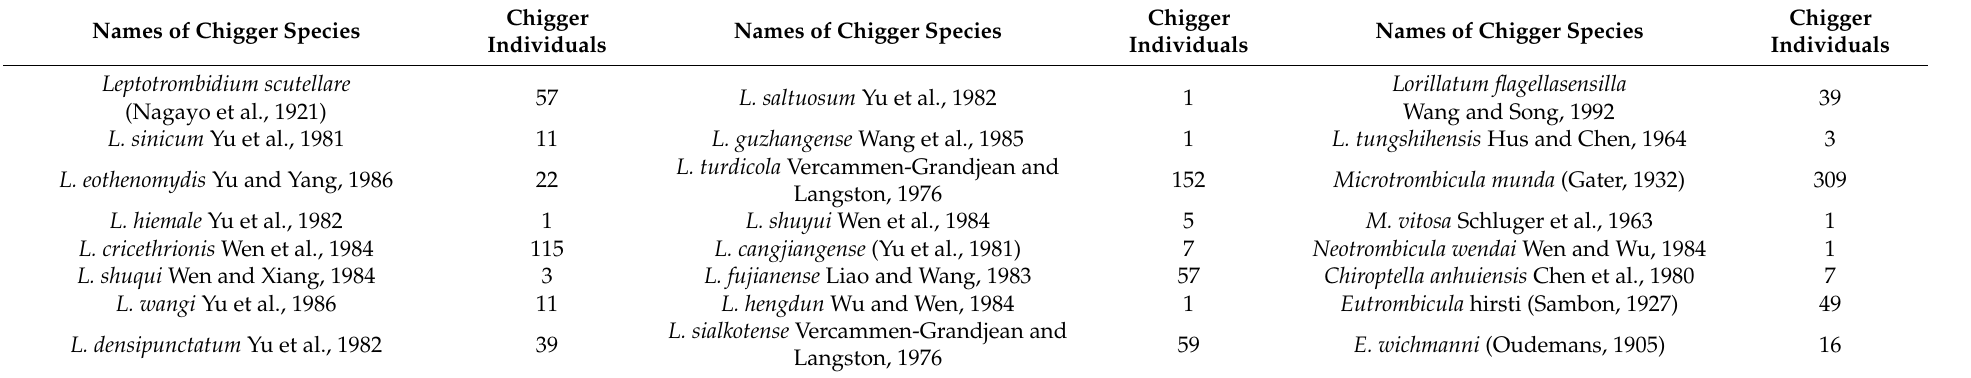
Table A2. Identified chiggers from oriental house rats ( Rattus tanezumi ) sampled in 5 provincial regions of Southwest China (2001–2019). Names of Chigger